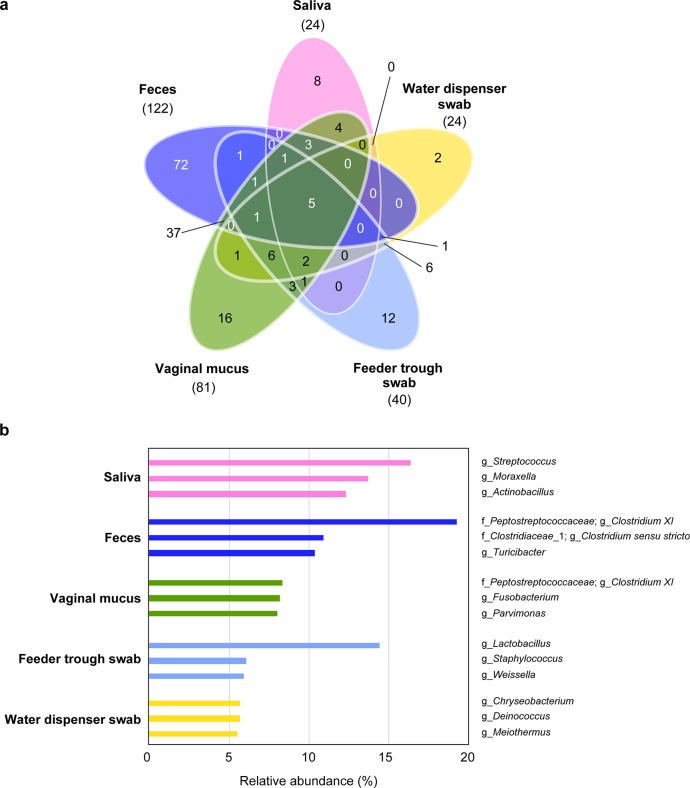
Common, unique and top three genera.(a) The Venn diagram presents the common and unique genera among the five sample groups. The number of common genera that were present in all samples in each group is indicated in parenthesis under each sample’s name. (b) The top three genera identified in the five sample groups.